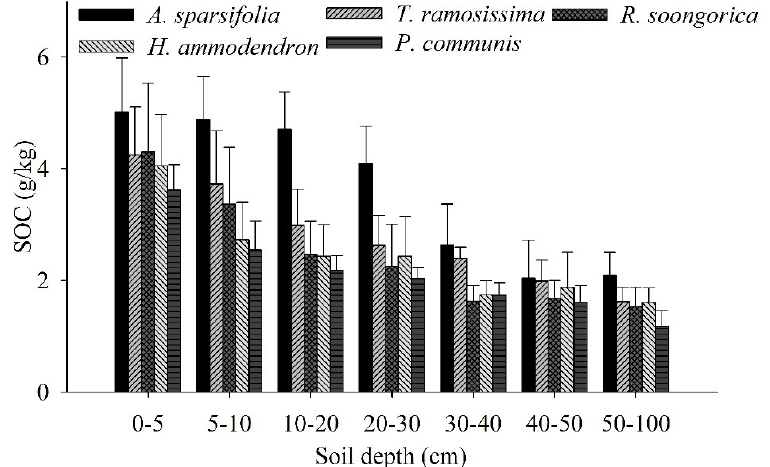
Figure 5. SOC (mean ± SD) of the five plant communities at soil depths of 0–100 cm. Each value represents the average of 3 three replicates.